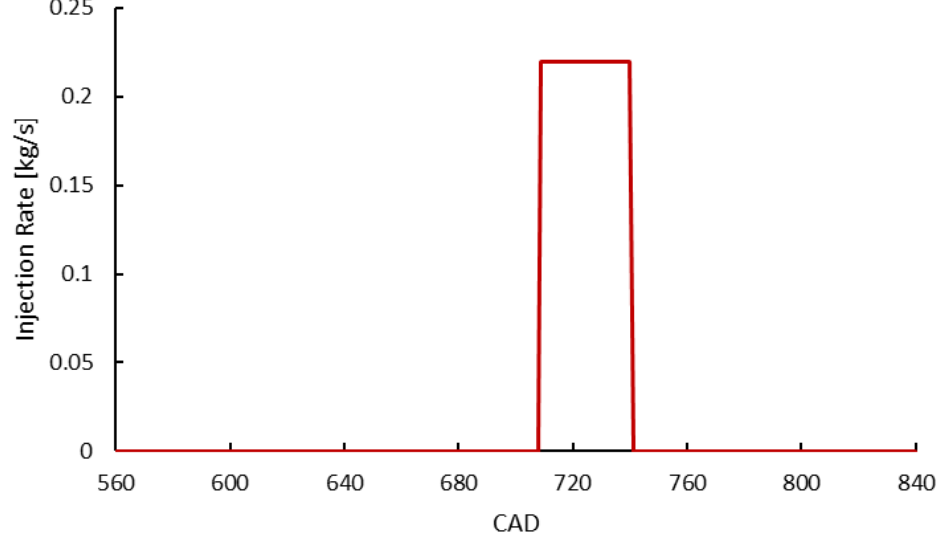
Figure 3. Single injection configuration of the engine.